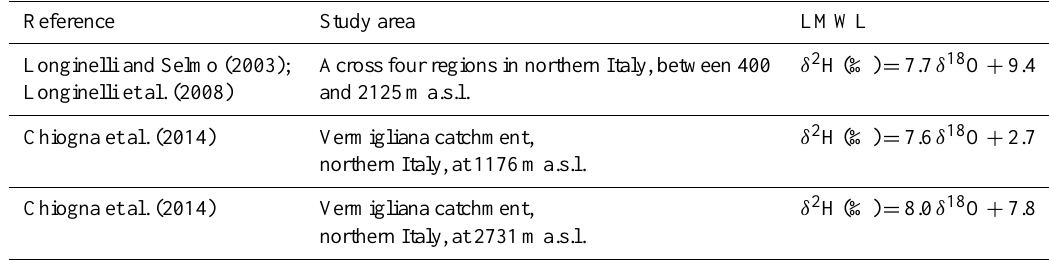
Table 3. Local meteoric water lines (LMWL) reported by different authors for mountain sites in northern Italy.